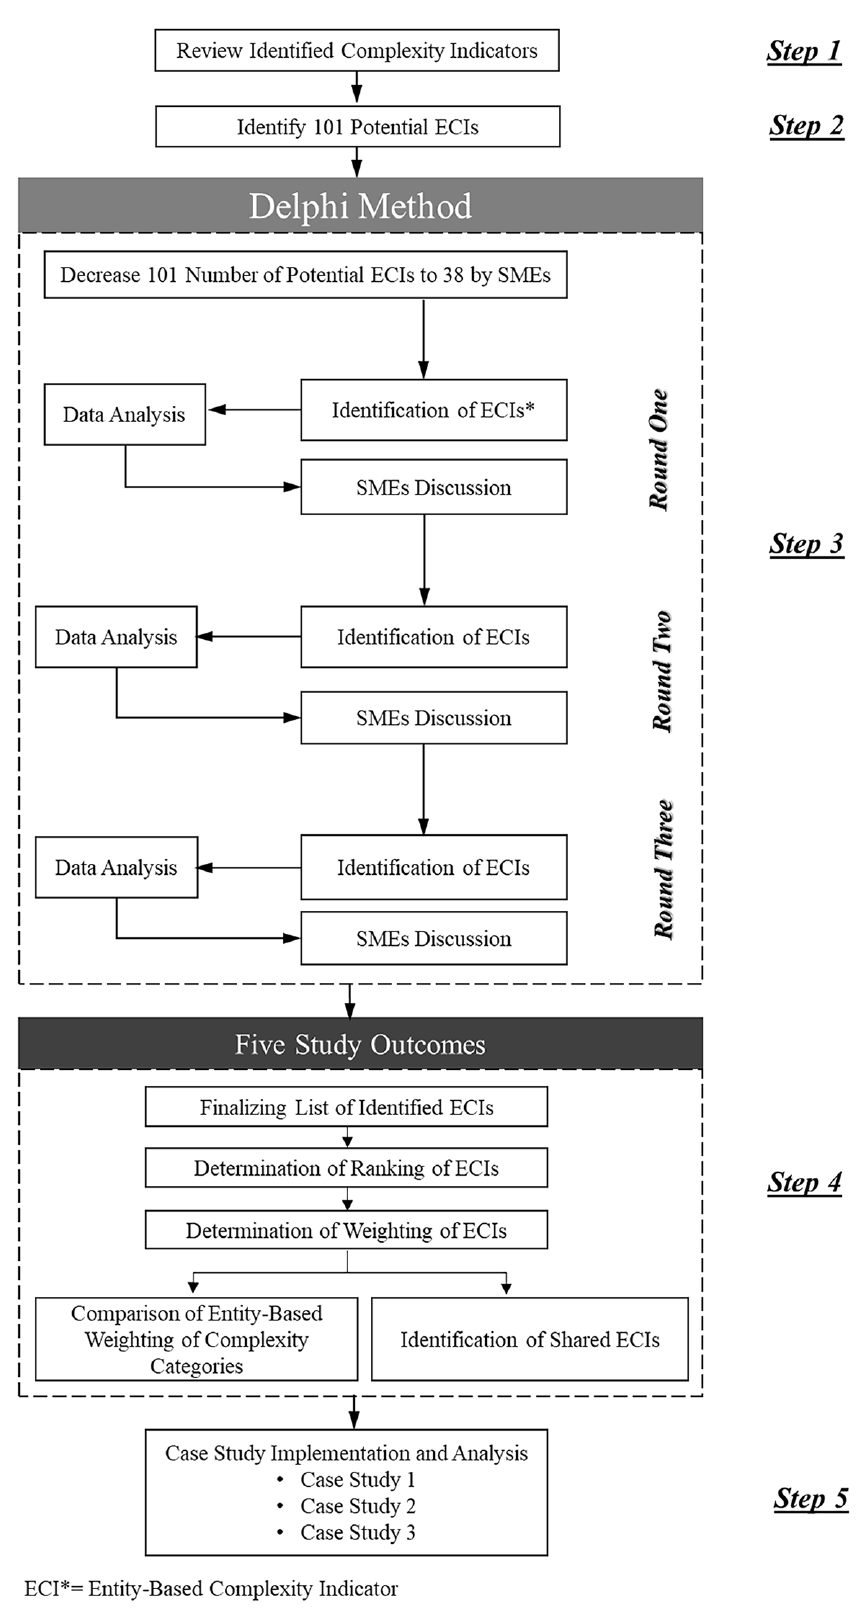
Figure 1. Research